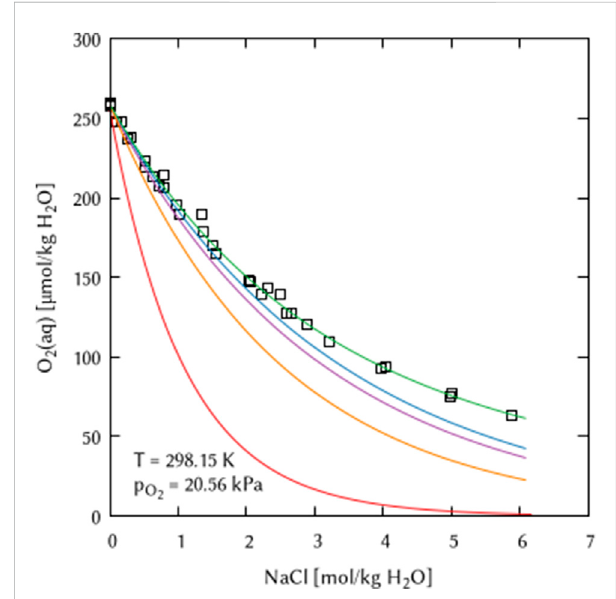
FIGURE 1 Effect of combining inconsistent Pitzer datasets on the example ofO 2 solubilityinNaClsolution. □ ExperimentaldatafromMilleroetal. (2002a), Millero et al. (2002b), Millero et al. (2003), lines: Calculation using the THEREDA Pitzer dataset (Moog et al., 2015; Voigt, 2020a; Voigt, 2020b; THEREDA, 2023) in combination with: blue) Millero et al. (2003), purple) Clegg and Brimblecombe (1990), orange) Geng and Duan (2010), red)Zheng andMao (2019), green)this